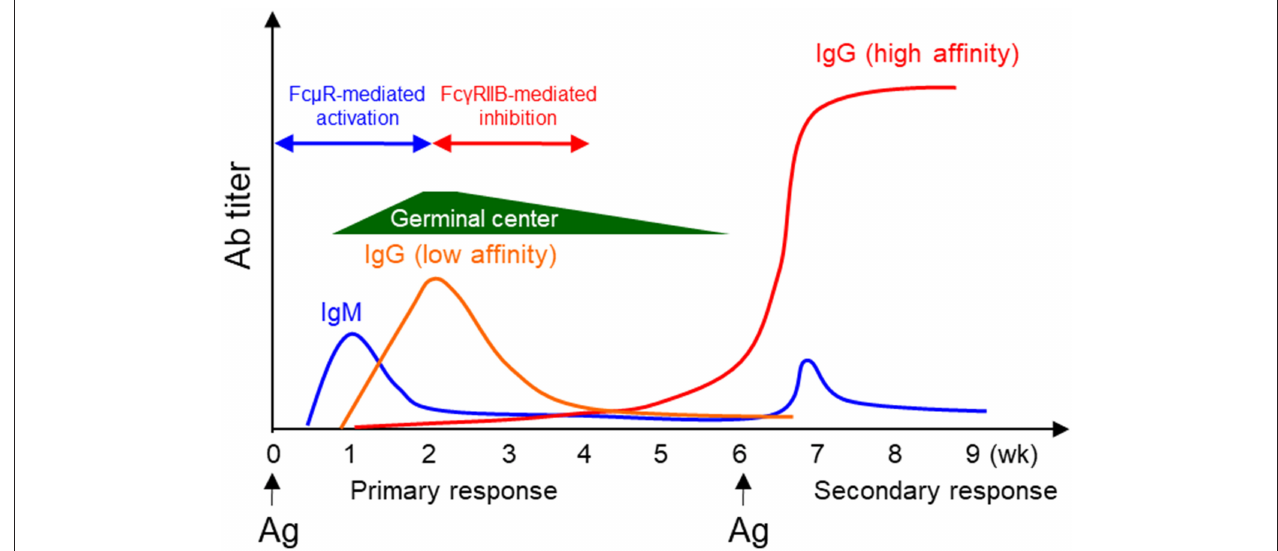
FIGURE 2 | Positive and negative regulation of humoral immune responses by Fc µ R and Fc γ RIIB. During a typical T-D humoral immune response, Ag-specific IgM is produced first, followed by IgG production. Based on the results that Fc µ R promotes B cell activation and Ab production and the earlier findings that Fc γ RIIB inhibits B cell activation and Ab production, we propose an autoregulatory mechanism for T-D humoral immune responses. During the early phase of the response, B cell activation is enhanced by Fc µ R-mediated positive signals. However, at a later phase of the response, further B cell activation is suppressed by Fc γ RIIB-mediated inhibitory